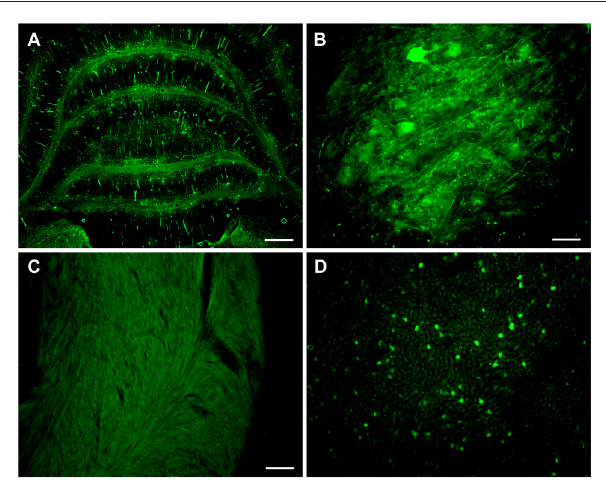
FIGURE 6 | Combining advantages for targeting and efficiency in a synapsin promoter-AAV-PHP.B vector. Neonatal rats were administered synapsin promoter-AAV-PHP.B intravenously, with an expression interval of 4 weeks. (A) Expression in the cerebellum. (B) Spinal cord. (C) The heart was blank for expression, as expected. (D) Importantly, the liver showed a relatively low level expression compared to previous CBA promoter-AAV9 vectors.